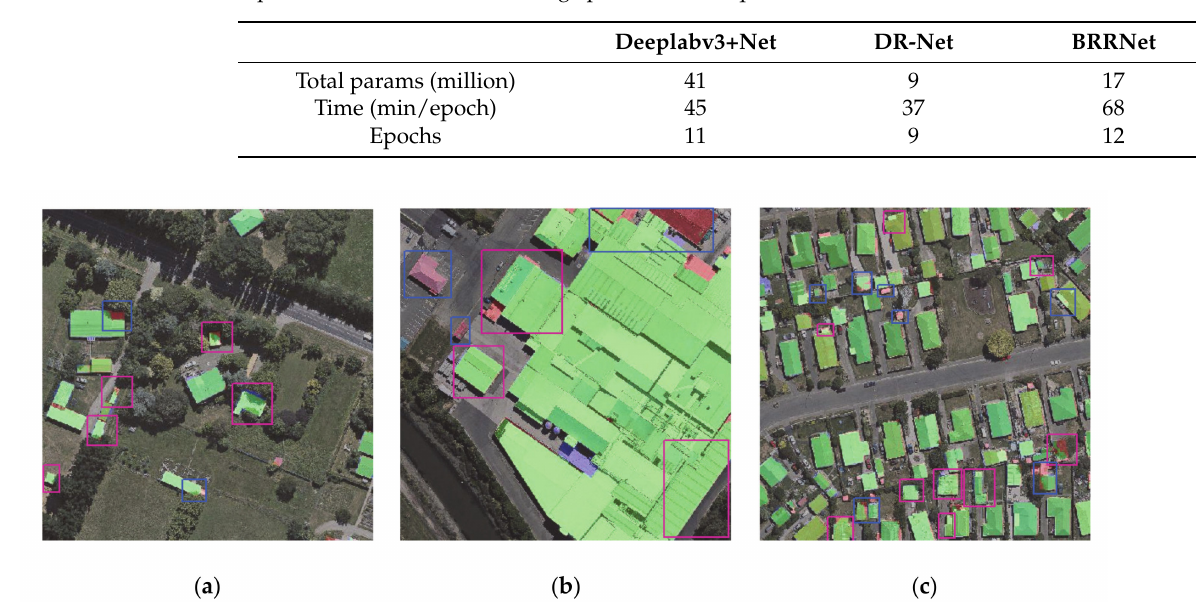
Table 3. The complexity of different networks. Row “Total parameters” represents the total parame- ters in a module; Row “Time” represents the time consumed in every training epoch; Row “epochs” represents the number of training epochs when acquire the best trained module.